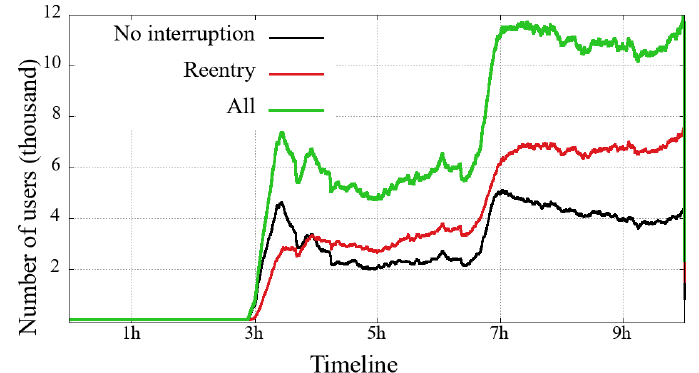
Figure 10. Mobile users on the system in the broadcasting session of Impeachment start session— Camara dos Deputados.